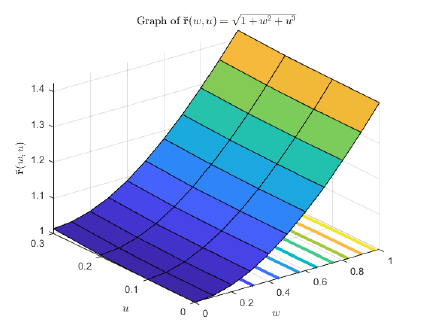
Figure 3. The graph of ˘p ( w , u ) in Example 2.